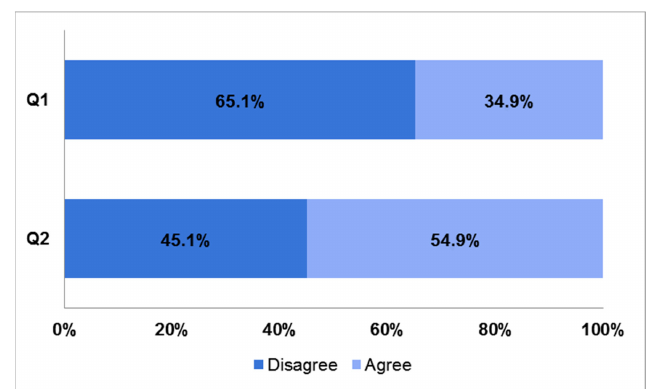
Figure 1. Bar charts showing responses to questions 1 and 2 of the survey. Q1: I had a clear career path plan when I entered medical school. Q2: My career path plan has been affected by near-peer tutoring experience.